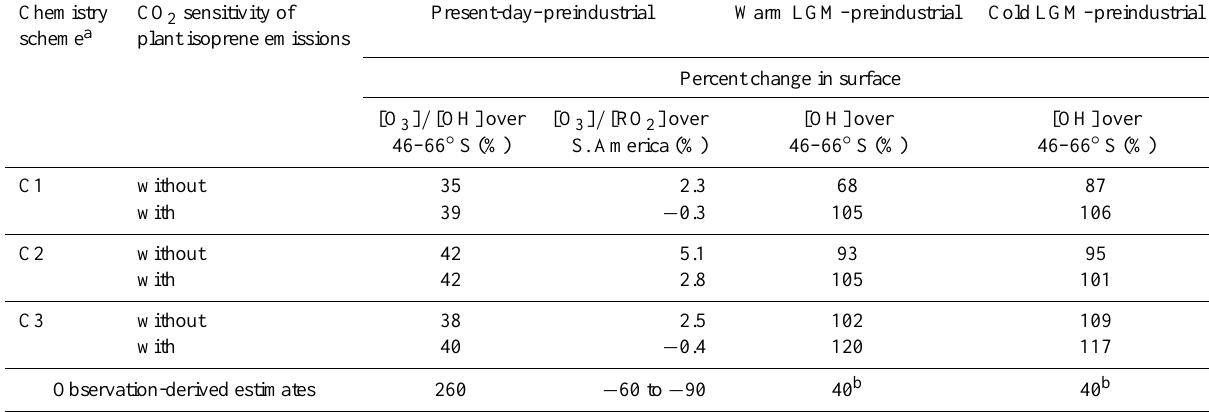
Table 4. Modeled percent changes in the surface [O 3 ] / [OH] and [O 3 ] / [RO 2 ] ratios for the present day relative to the preindustrial and in the surface [OH] concentration for the warm and cold LGM relative to the preindustrial for different model sensitivity experiments. Surface [O 3 ] / [OH] and [OH] values are averaged over the 46–66 ◦ S latitude band to compare with values inferred from ice-core measurements of (cid:49) 17 O(SO 2 − ) by Sofen et al. (2014) and Alexander et al. (2002). Surface [O 3 ] / [RO 2 ] are averaged over 34–54 ◦ S and 62.5–72.5 ◦ W 4 (extratropical South America) to compare with values inferred from ice-core measurements of (cid:49) 17 O(NO − described in Sect.